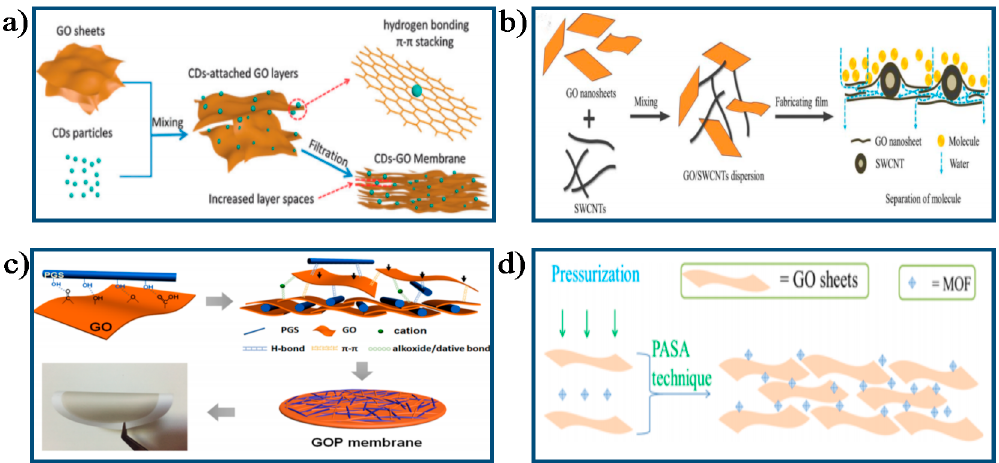
Figure 5. Schematic diagram of the process tuned the structure of GO membrane by physical